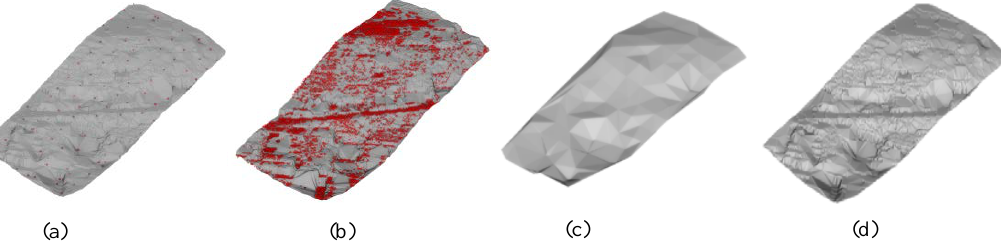
Figure 21. Results of representative sample: ( a ) Overlay result of reference DTM and ground seed points (red points) produced by PTDF, ( b ) overlay result of reference DTM and ground seed points (red points) produced by the proposed algorithm, ( c ) initial provisional DTM generated from ground seed points of ( a ), ( d ) initial provisional DTM generated from ground seed points of (b).